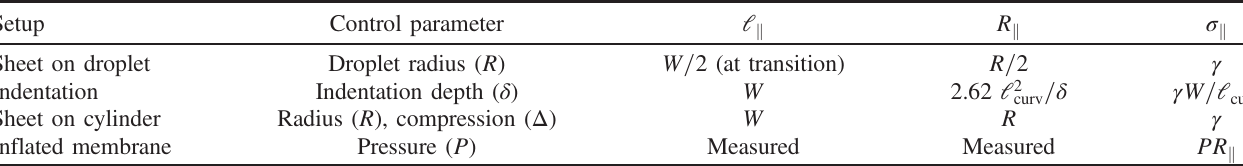
being the capillary length [18,20]. The curvature R − 1 k ð r Þ ¼ ζ 00 ð r Þ